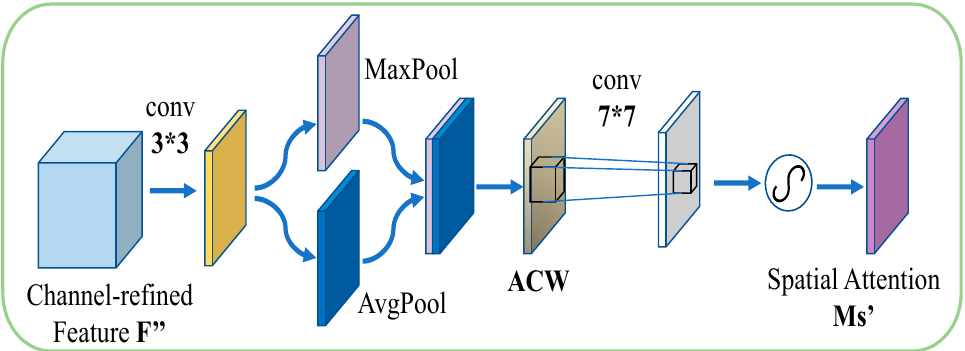
Figure 7. Attention module (ASA) structure diagram.